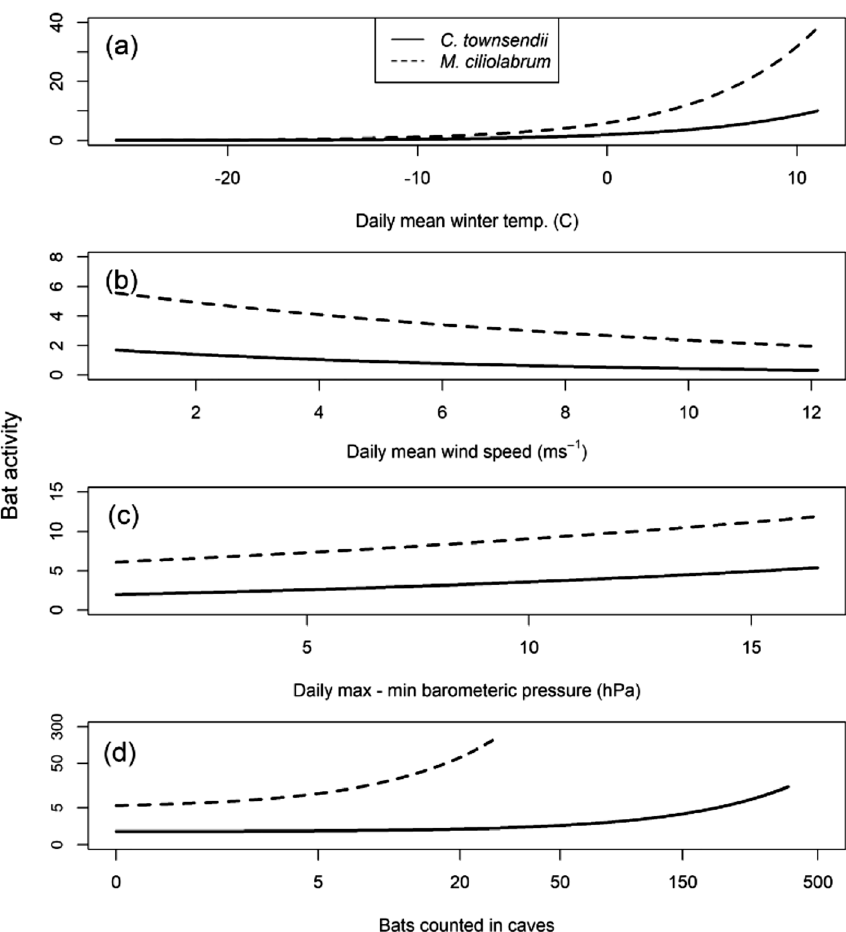
Figure 2. Fitted models while holding predictor variables constant for bat activity (files/night) in 9 hibernacula for Townsend’s big-eared bats ( Corynorhinus townsendii ) and western small-footed myotis ( Myotis ciliolabrum